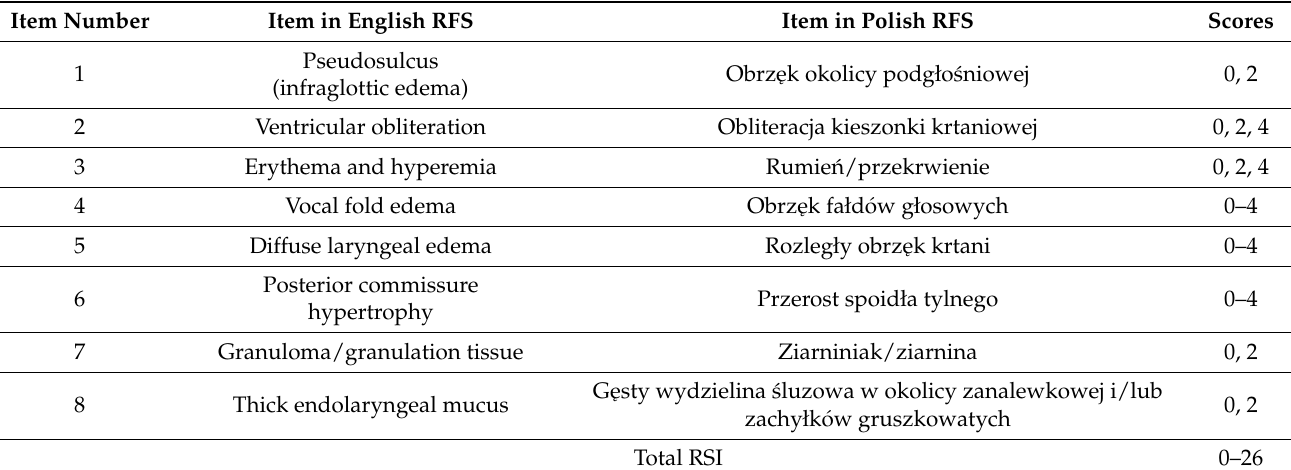
Table 2. The RFS scale with each item translated into Polish.